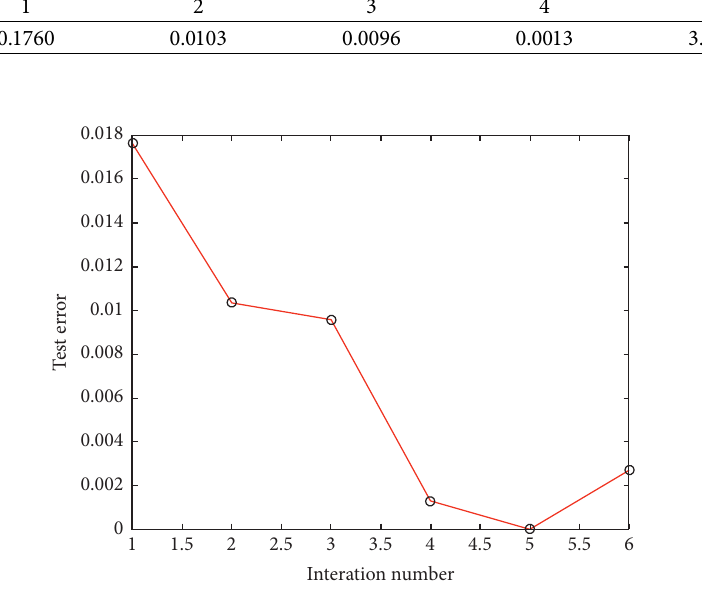
Figure 5: Test error curve of the rectangular